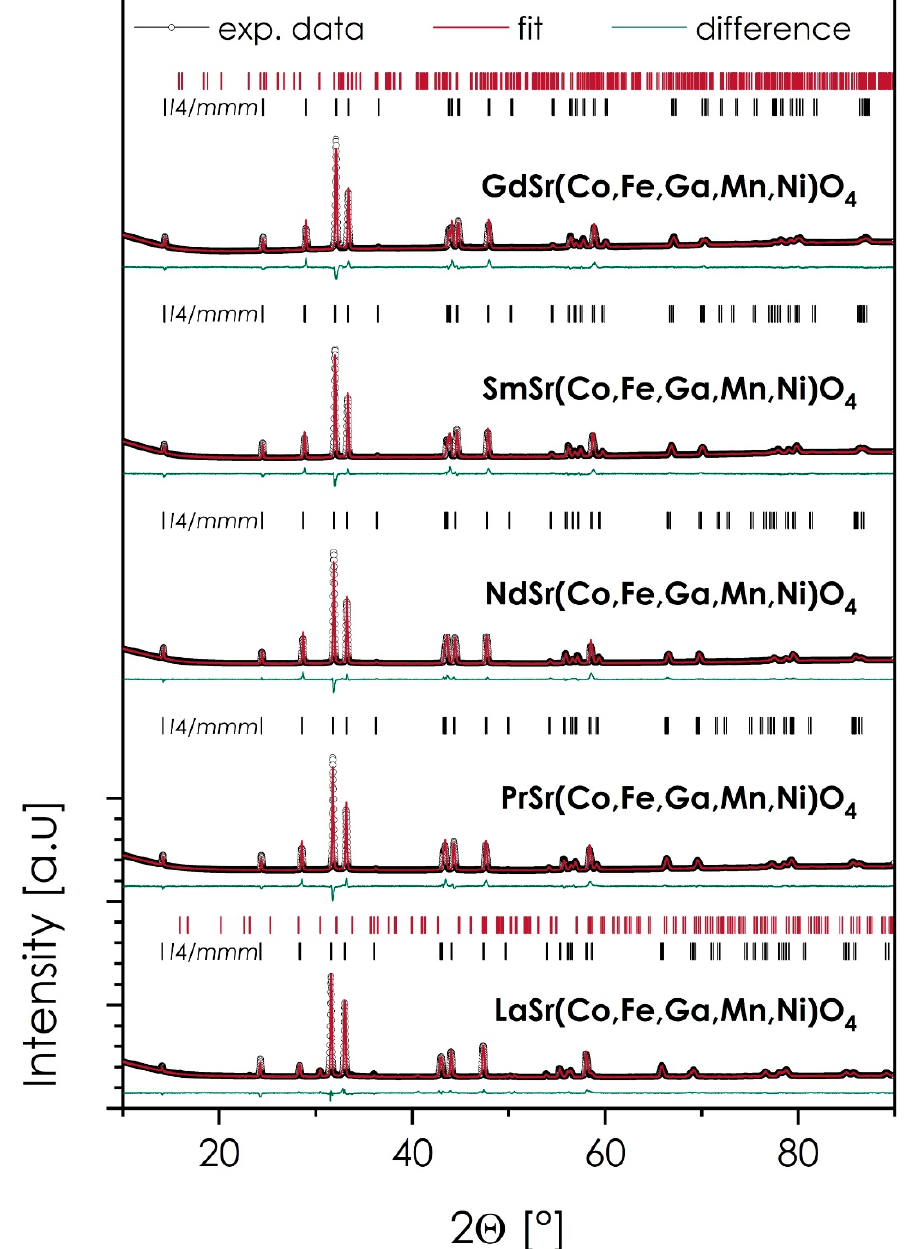
Figure 1. XRD diffractograms, together with the results of Rietveld refinement for the LnSr(Co,Fe,Ga,Mn,Ni)O 4 (Ln = La, Pr, Nd, Sm, or Gd) materials, sintered at 1200 °C for 20 h.